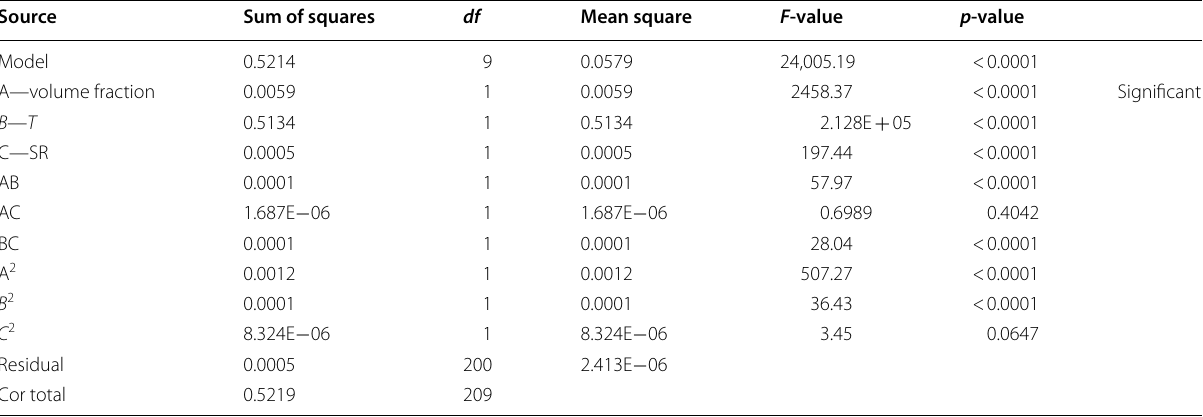
Table 10 VAAN for the quadratic